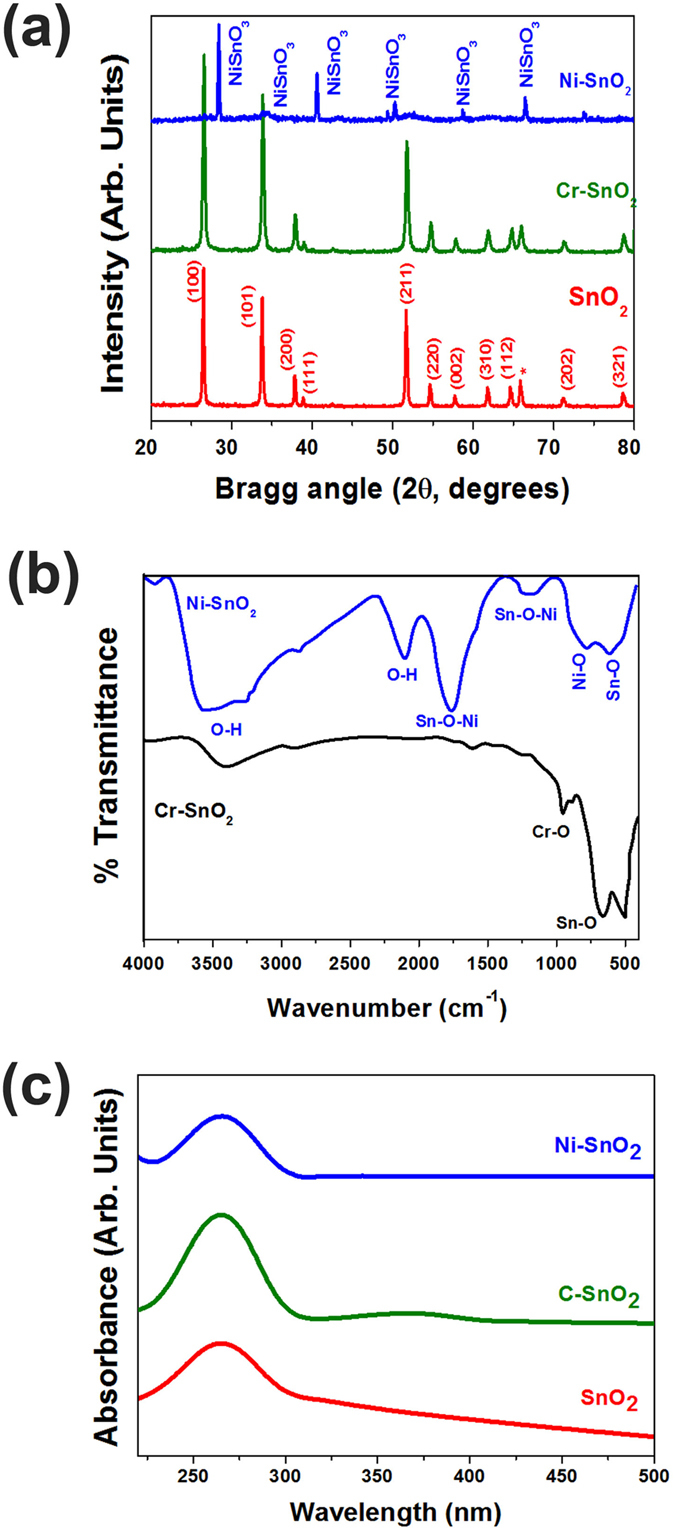
(a) X-ray diffraction patterns of pristine SnO2 and Ni & Cr-doped SnO2 powder, (b) FT-IR spectrum of Ni and Cr-doped SnO2 powder and (c) UV-Visible spectra of pristine SnO2 and Ni & Cr-doped SnO2 powder.